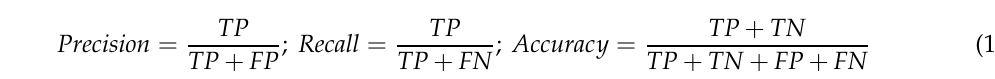
Figure 1. ROC curve of the classification: HWT, SNR = 100 dB.